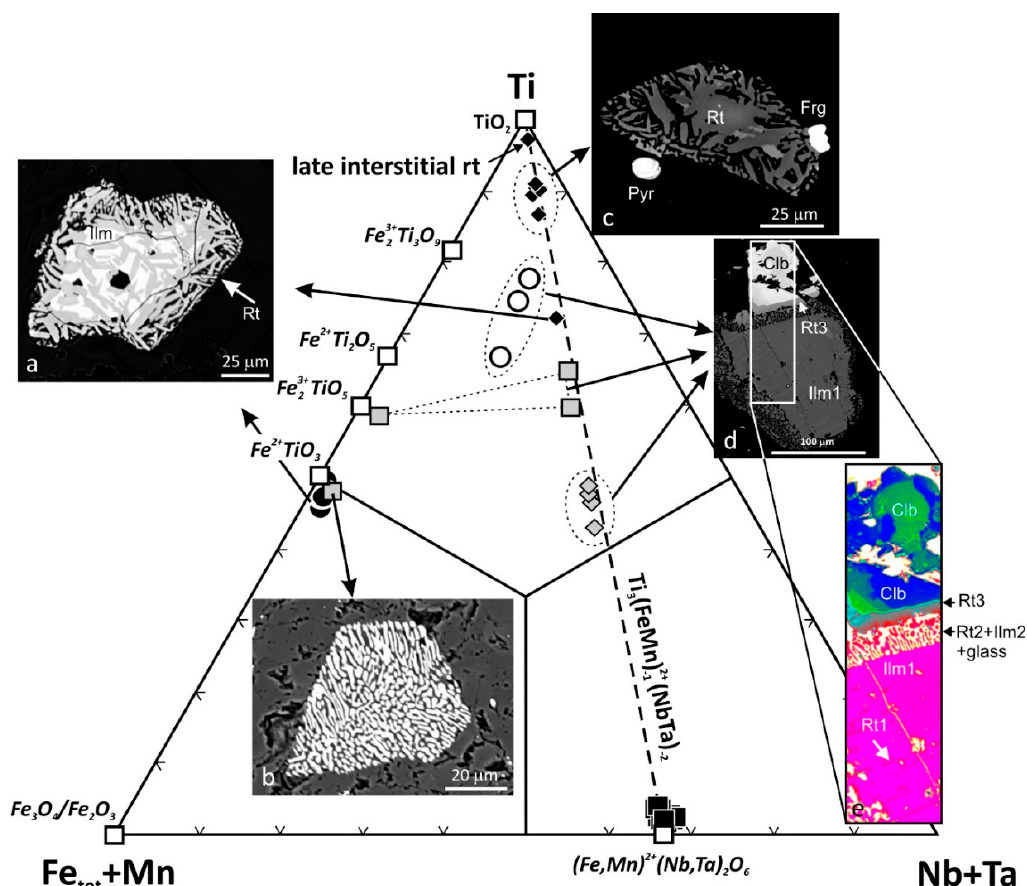
Figure 6. The triangular plot of Ti–(Fe,Mn)–(Nb,Ta) atomic proportions with projection points of ideal endmembers (open squares, formulas in italics) and EPMA data on Nb,Ti,Fe,Mn-oxides from Č amovce [17]. Open circles represent rutile exsolutions (Rt1) in ilmenite (Ilm1), shaded squares are symplectic ilmenite (Ilm2) and rutile (Rt2) replacing the early ilmenite Ilm1, shaded diamonds are compact rutile rims (Rt3) between ilmenite and columbite, solid diamonds correspond to the euhedral rutile replacing early ilmenite (solid circles). Selected rutile and ilmenite types are documented in inserted BSE images ( a–d ). The false color-coded sector ( e ) visualizes the rutile-ilmenite-silicate glass symplectite grading into the compact rutile, as well as Nb–rutile exsolutions within the ilmenite host. Niobium and tantalum contents tend to increase from Ilm1 (up to 3.8 wt. % Nb 2 O 5 + Ta 2 O 5 ), through Rt1 (up to 22 wt. %), Rt2 (up to 37 wt. %), Rt3 (47–51 wt. %), to columbite (78 wt. %). Blue domains in the columbite are enriched in Ta (up to 16.5 wt. % Ta 2 O 5 ). Ilm1 is enriched in Mn (up to 11.8 wt. % MnO) and Sm (1.1 wt. % Sm 2 O 3 ).